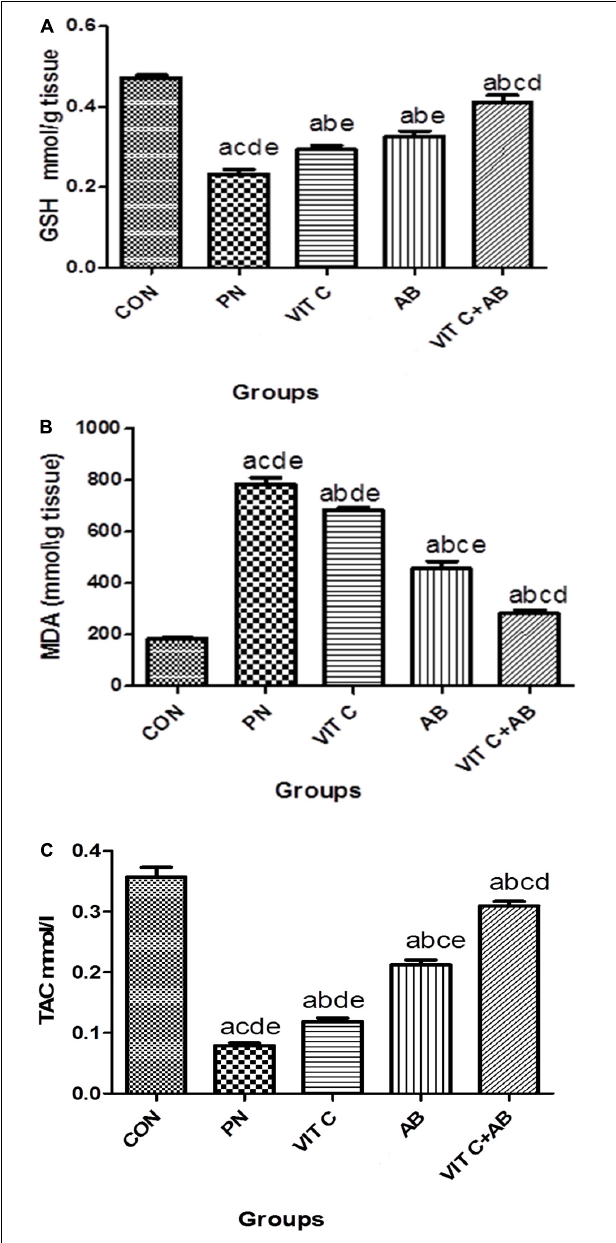
FIGURE 5 | Oxidative stress parameters of different rat groups. (A) Glutathione (GSH) in lung tissue, (B) malondialdehyde (MDA) in lung tissue, (C) total antioxidant capacity (TAC) in serum. a Significant difference compared to PN group. b Significant difference compared to VIT C group. c Significant difference compared to AB group. d Significant difference compared to VIT C+AB group. PN, pneumonia group; VIT C, vitamin C; AB,